Question: Write a caption explaining this figure to a reader.
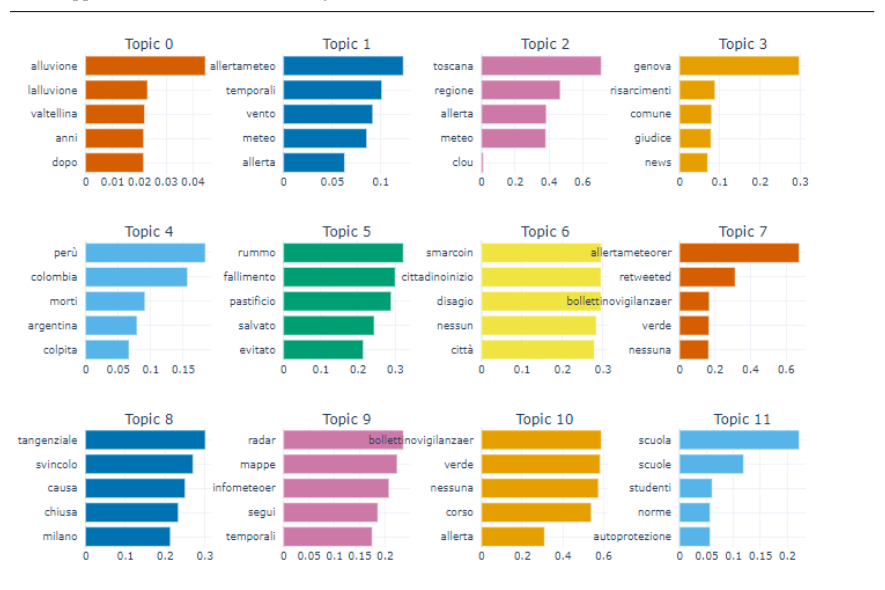
Answer: Word scores of the topics extracted from the complete set of relevant tweets.